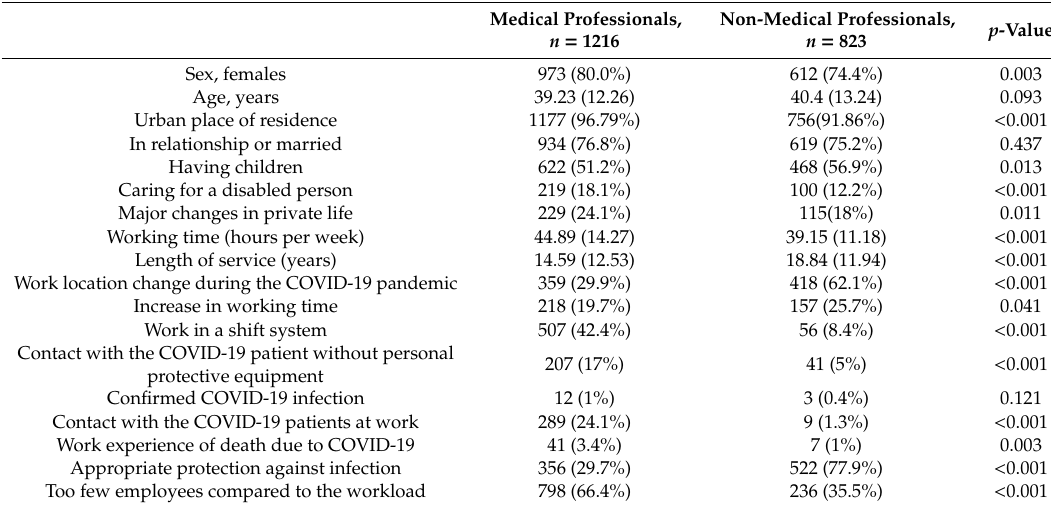
Table 1. General characteristics of medical professionals and individuals representing non-medical